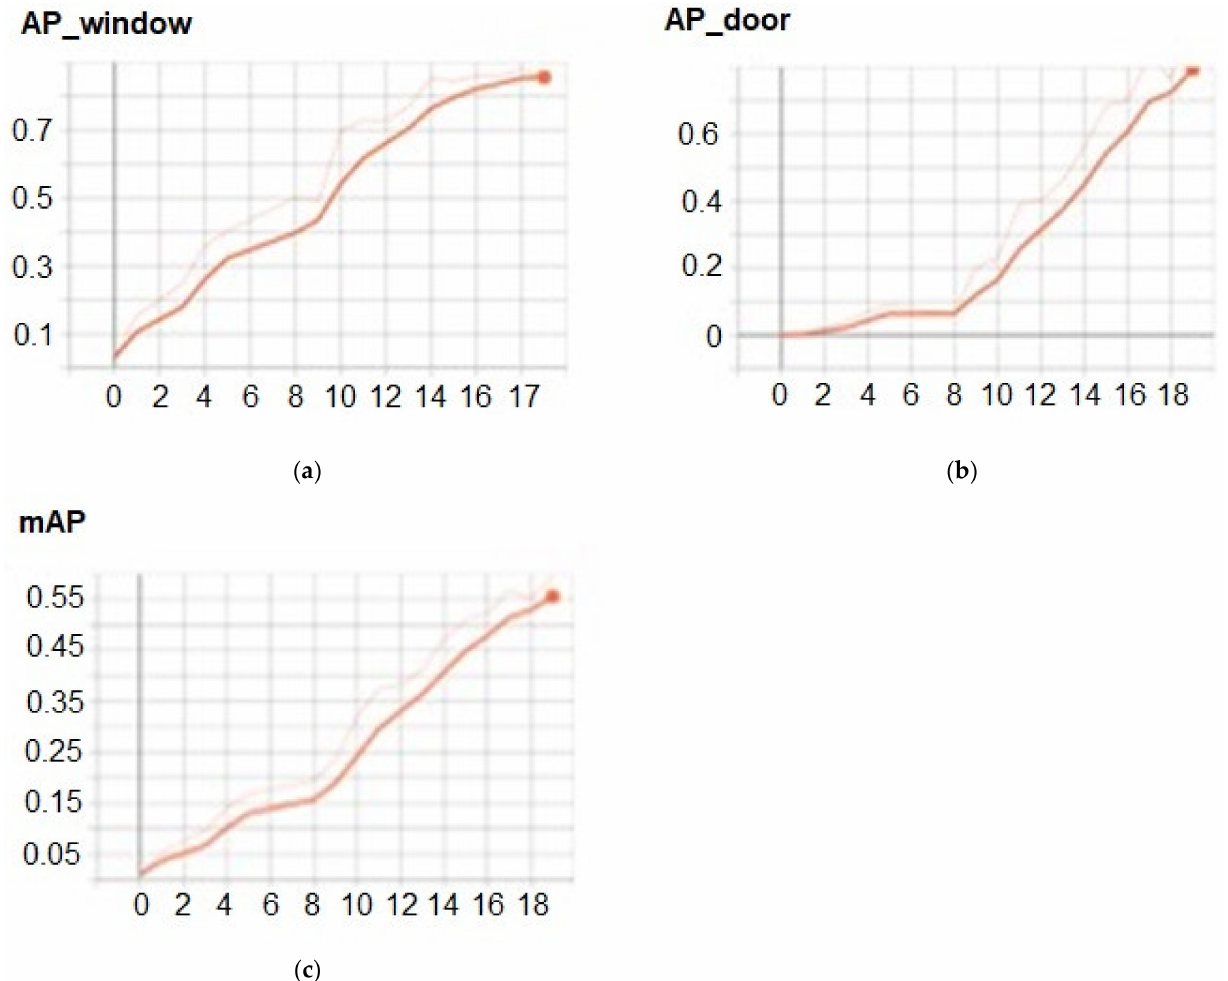
Figure 3. Training parameters for custom dataset: ( a ) average precision for window detection; ( b ) average precision for door detection; ( c ) mean average